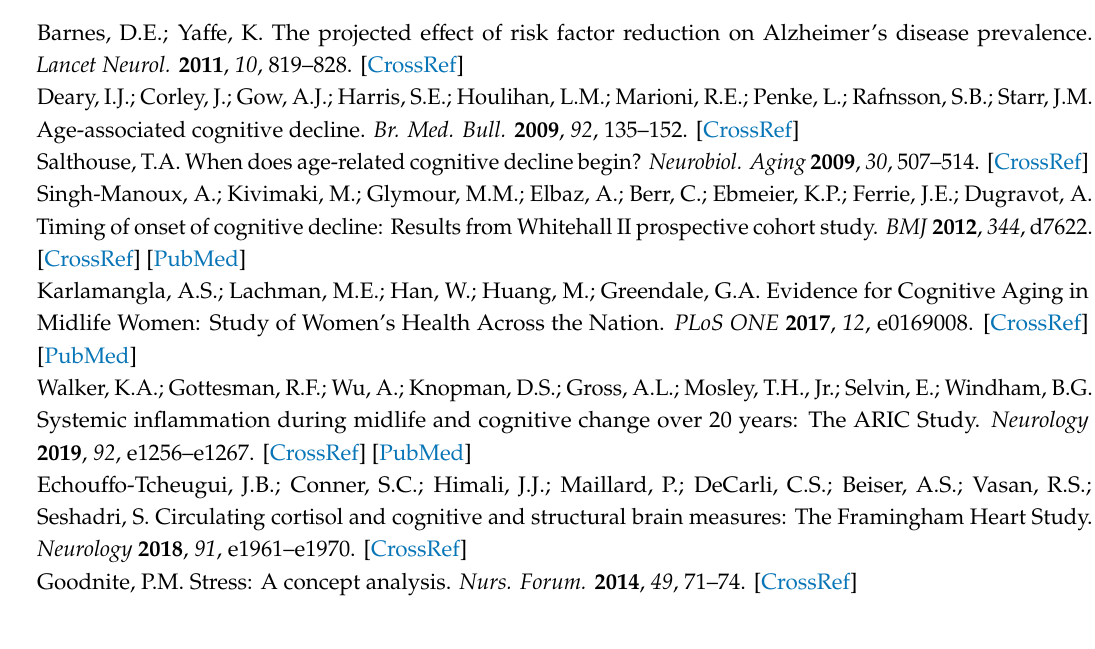
Table S1. Descriptions of the Cambridge Neuropsychological Test Automated Battery (CANTAB) tasks used in the current study; Table S2. The Cambridge Neuropsychological Test Automated Battery (CANTAB) outcome measure characteristics; Table S3. Reference values of self-report instrument; Table S4. Reference values of biochemistry